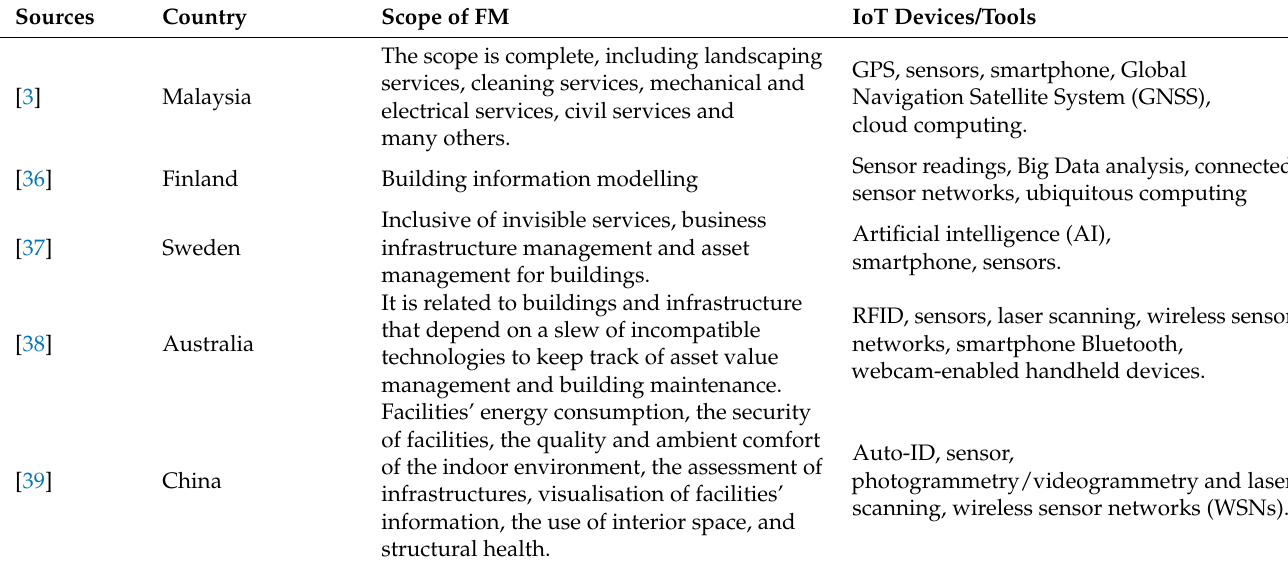
Table 1. Scope of IoTbs for FM.